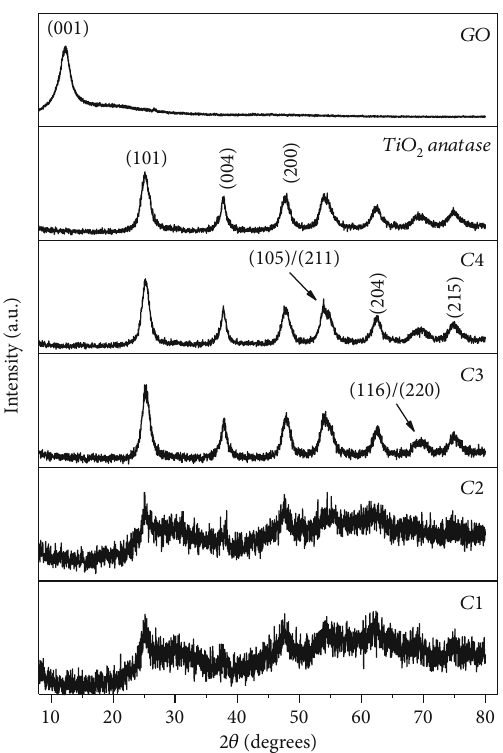
Figure 1: XRD di ff raction patterns of GO, TD, and the composite materials C1, C2, C3, and